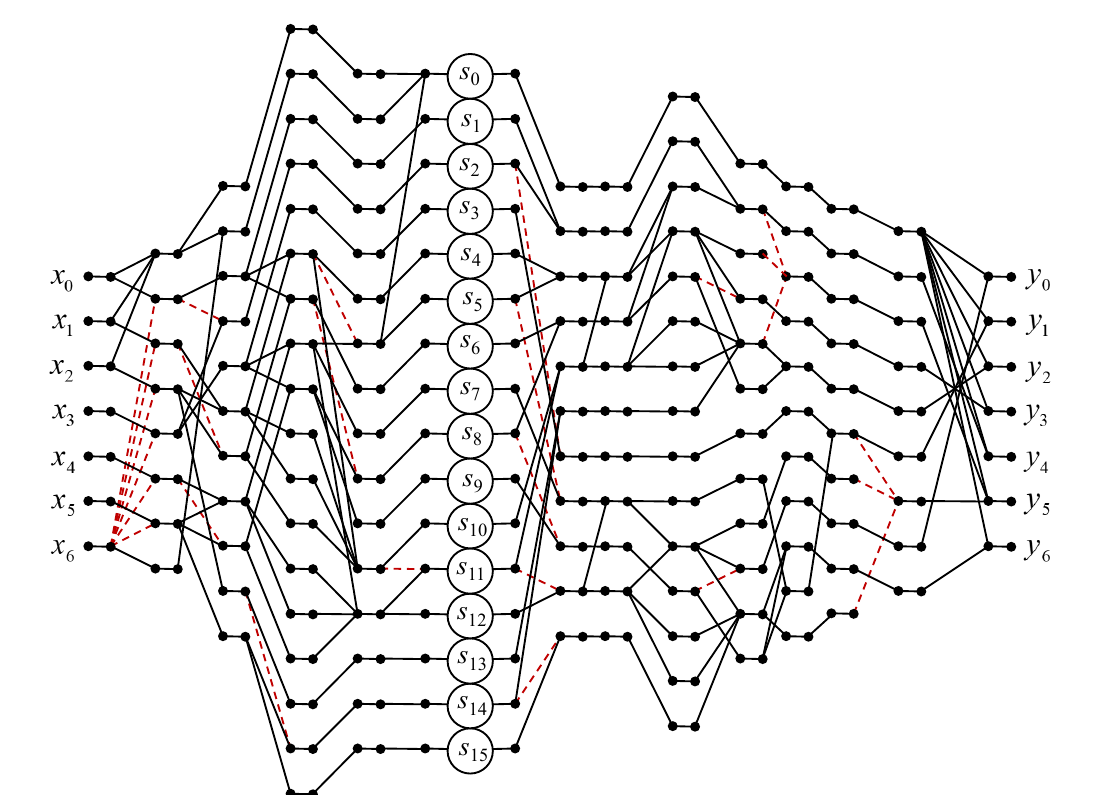
Figure 6. Algorithmic structure of the processing core for the computation of the 7-point circular